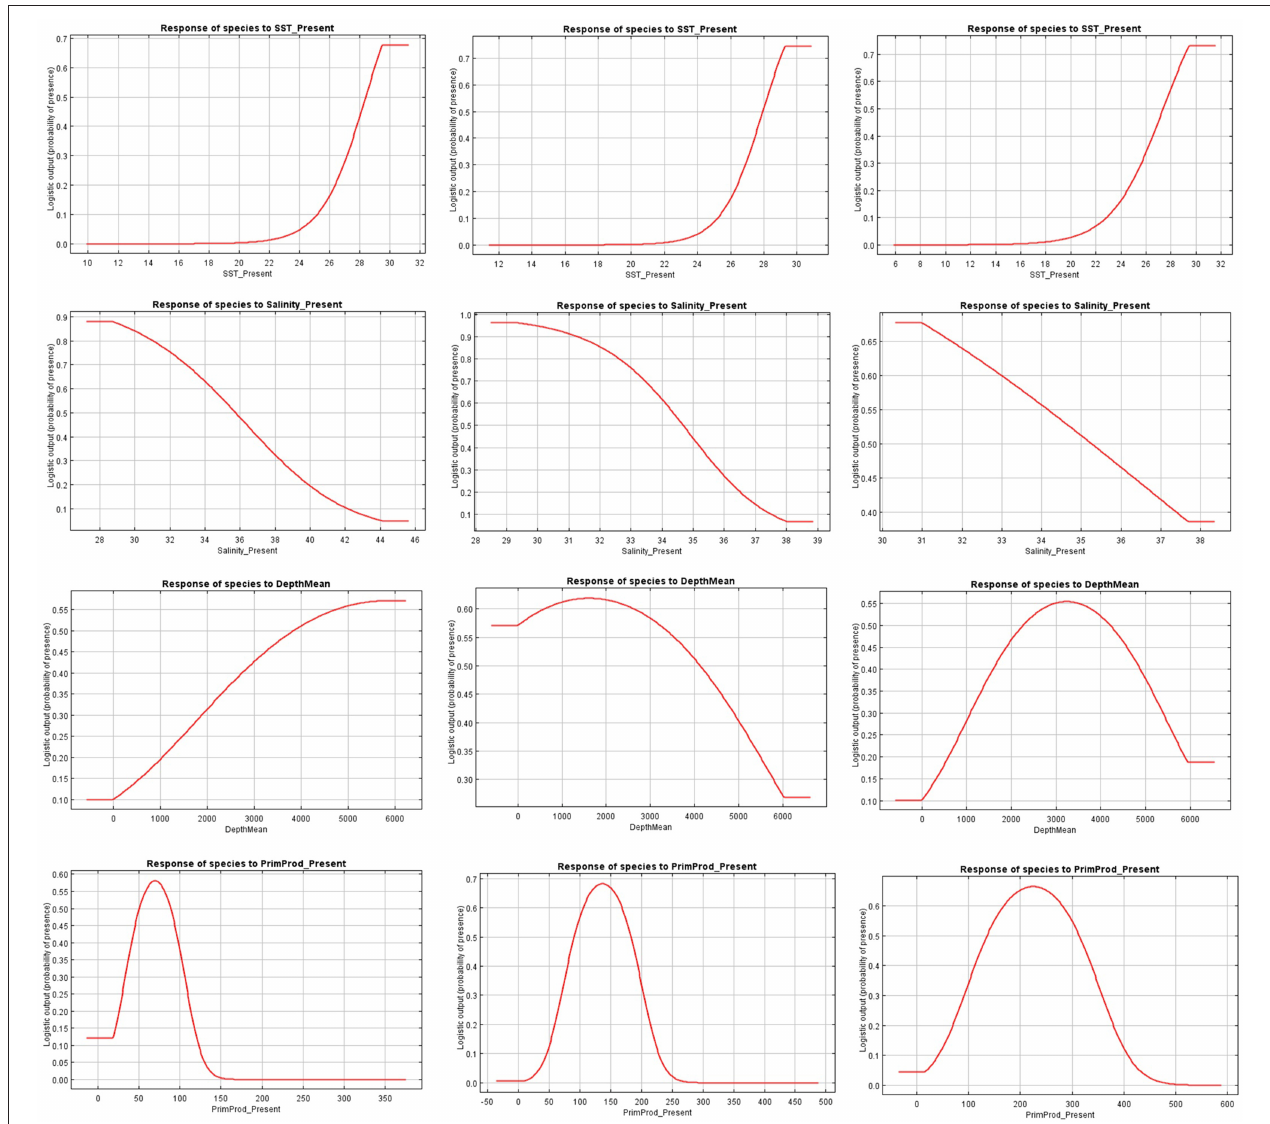
FIGURE 3 | Present response curves (sea surface temperature, salinity, depth, and primary production) for Carcharhinus falciformis in the Indian (first column), Atlantic (second column), and Eastern Pacific Ocean (third column).